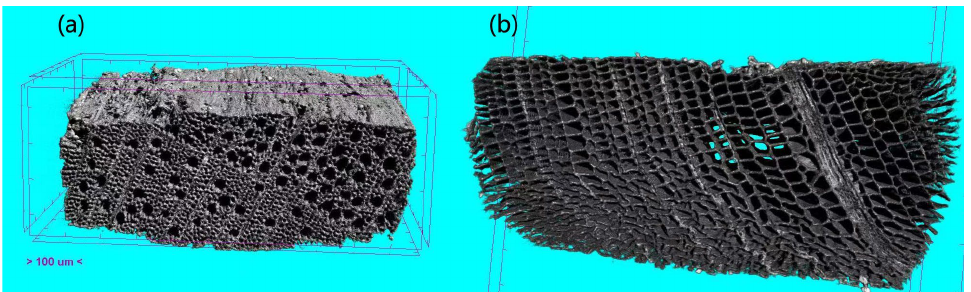
Figure 3. The transverse section images of AWW ( a ) and pine wood ( b ) obtained by microcomput- erized